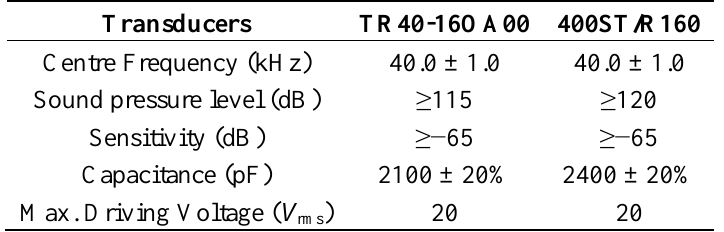
Table 1. Main technical characteristics of the transducers used.